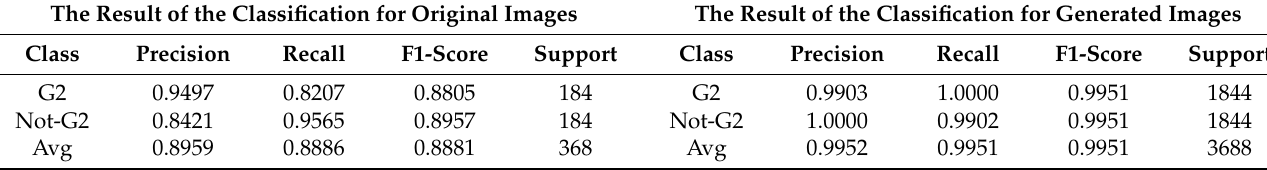
Figure 9. The images of the G2 class and the non-G2 class. ( a ) Images of G2 class [13]; ( b ) images of non-G2 class [13]; ( c ) images generated by WGAN-GP of G2 class; ( d ) images generated by WGAN-GP of non-G2 class. Table 9. The classification results for original images and generated images. Table 9. The classification results for original images and generated images.